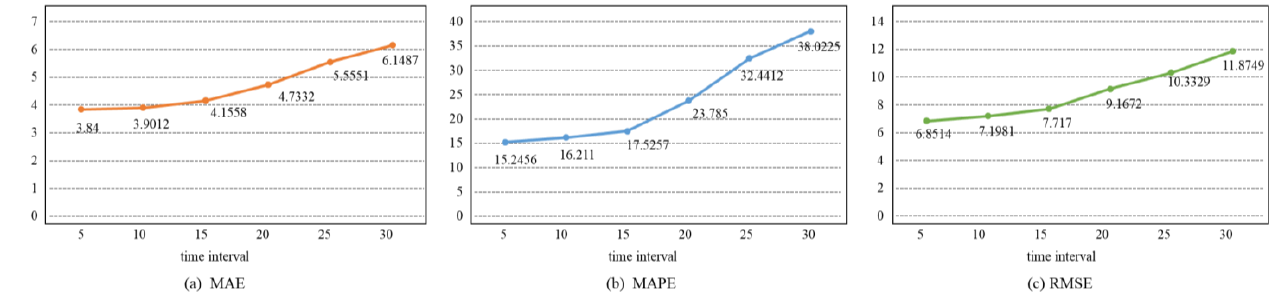
Figure 10. Comparison of prediction impacts over different time intervals.